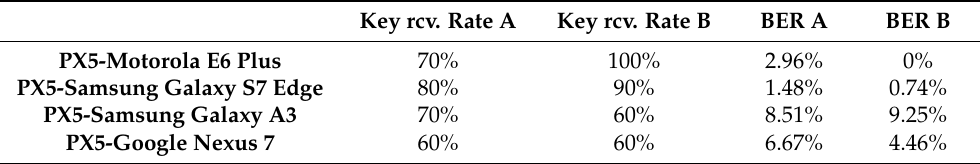
Table 8. Pairing success rate and BER for infotainment experiments without environment noise.